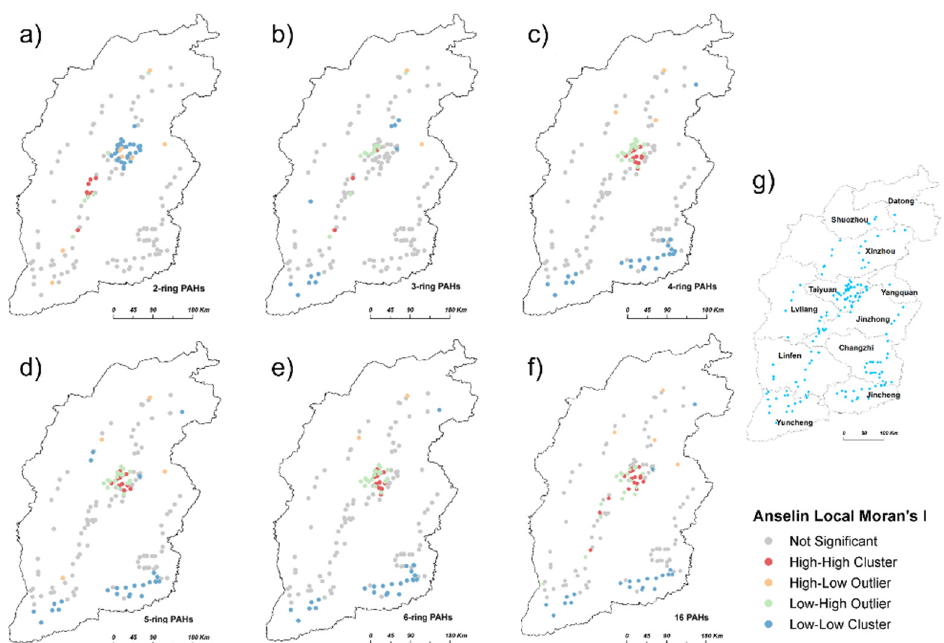
Figure 4. Clustering and outlier analysis of soil ∑ 16 PAHs and PAHs with different ring numbers in Shanxi Province, using the local indicators of spatial association method (LISA). ( a ) 2-ring PAHs; ( b ) 3-ring PAHs; ( c ) 4-ring PAHs; ( d ) 5-ring PAHs; ( e ) 6-ring PAHs; ( f ) ∑ 16 PAHs; ( g ) schematic diagram of administrative division of Shanxi Province.